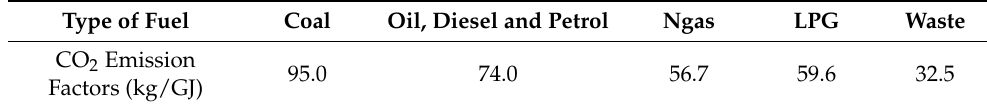
Figure 8. RES and clean energy share in the seven scenarios. 3.3. Installed Capacity The share of fossil fuel power plants is expected to decrease significantly in Guangxi due to their harmful effects on the environment and the government ’ s policy to reduce the average power supply coal consumption of thermal power units year by year. As can be seen from Figure 9, along with the shutdown of small coal power plants and the trans- formation of the energy structure of large thermal power plants, traditional thermal power plants will be replaced by clean energy power plants, and the share of installed fossil energy capacity will decline from 2020 to 2050, with the overall proportion decreas- ing by a maximum of 28%.